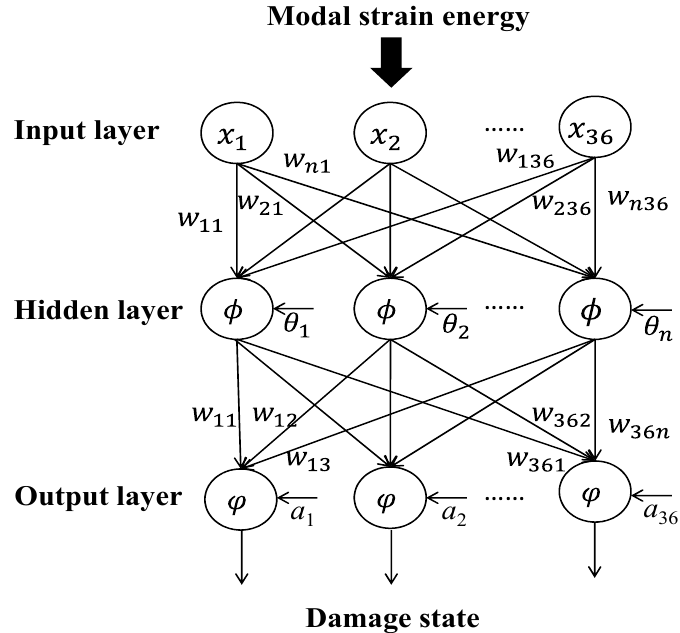
Figure A3. Topology of the back propagation (BP) neural network.